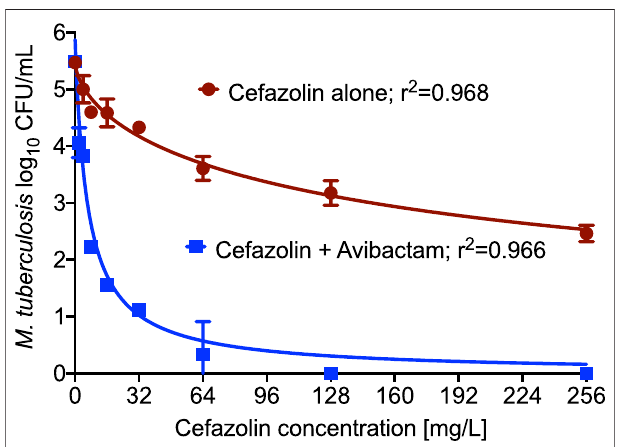
FIGURE 1 | Cefazolin concentration response against M. tuberculosis . Additionof β -lactamaseinhibitor,avibactamresultedinimprovedkillingof Mtb as well as lower EC 50 compared to the cefazolin alone.